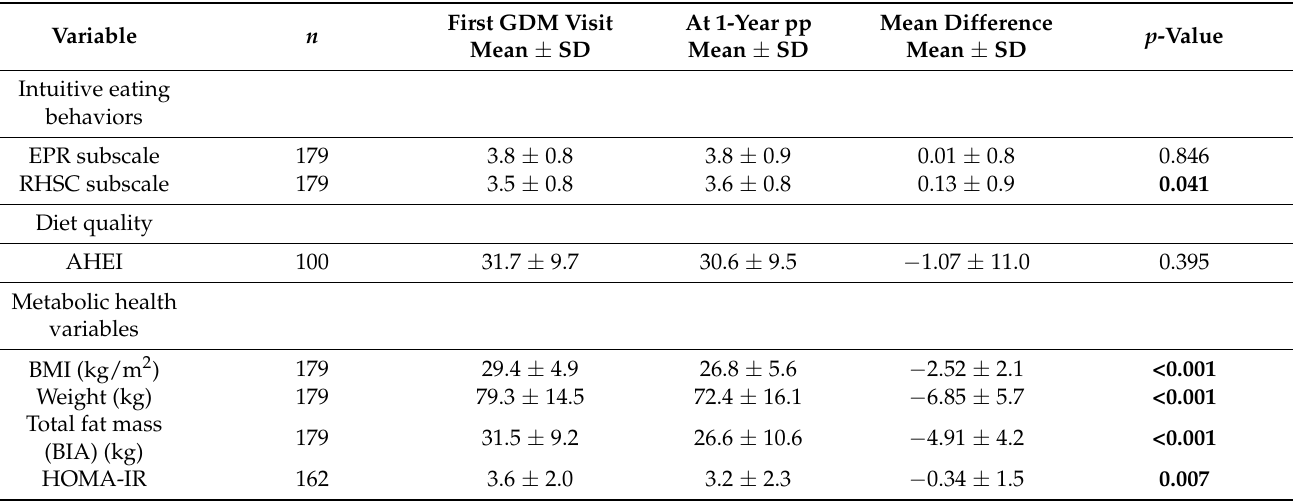
Table 2. Frequency, mean and standard deviation of study variables at baseline and end of the